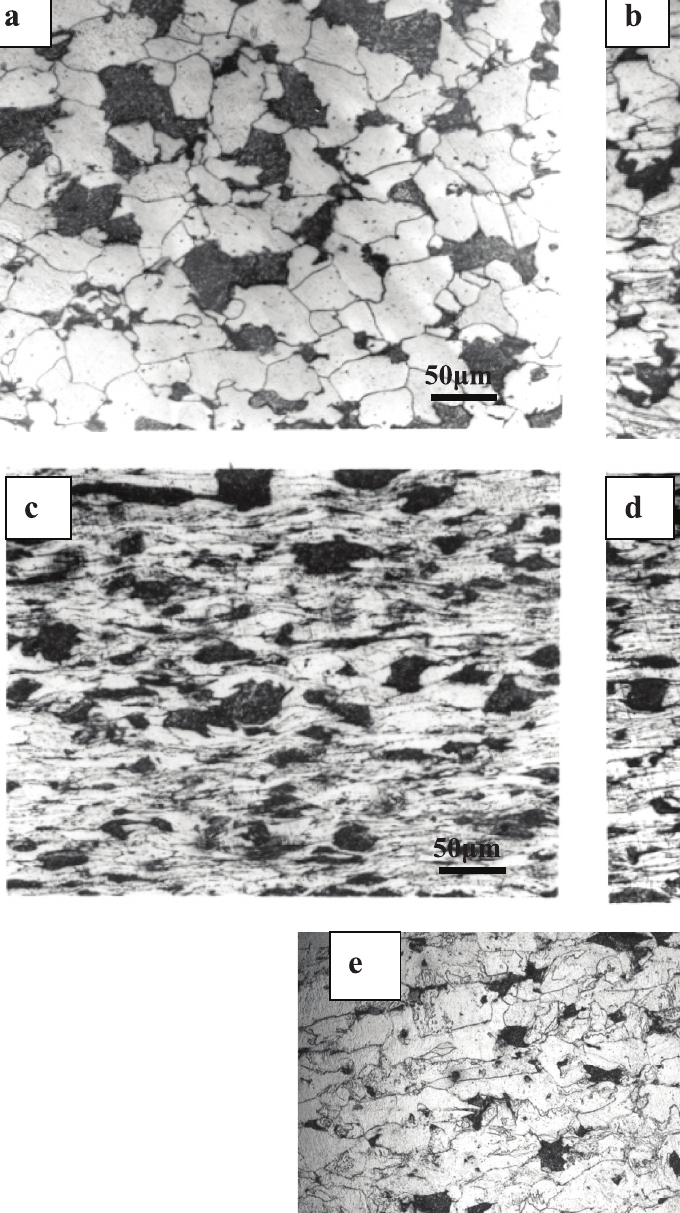
indicates that the parabolic rate constant increases with increase percentage of cold deformations up to 50.45% deformations. However, the parabolic rate constant shows opposite kind of behavior above 50.45% deformations (i.e. the parabolic rate constant decreases with the increase of percentage of cold deformations).